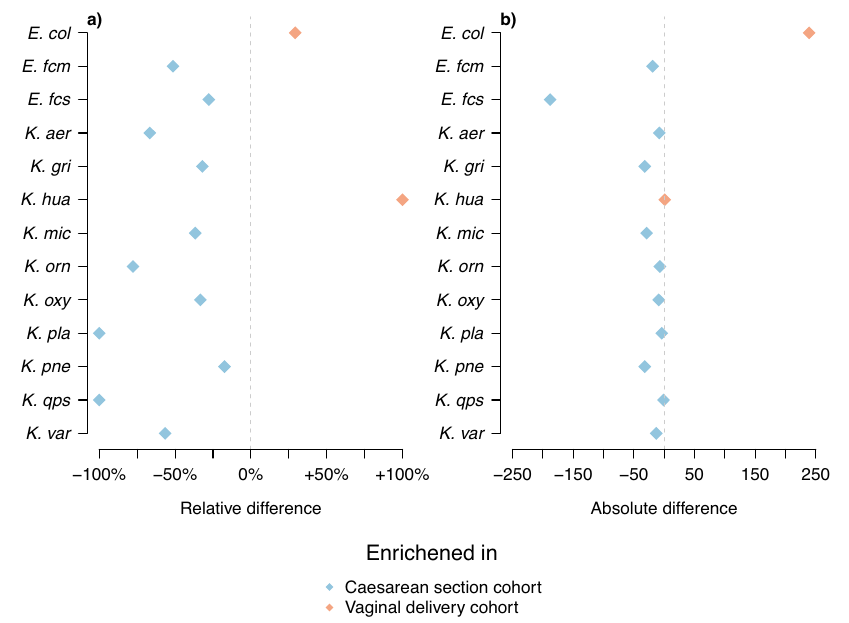
Fig. 2 | Differences in pathogen loads between cohorts. The fi gure shows differences in the number of reliably identi fi ed pathogens in each cohort. a The relative differences between the cohorts, and b the absolute differences.